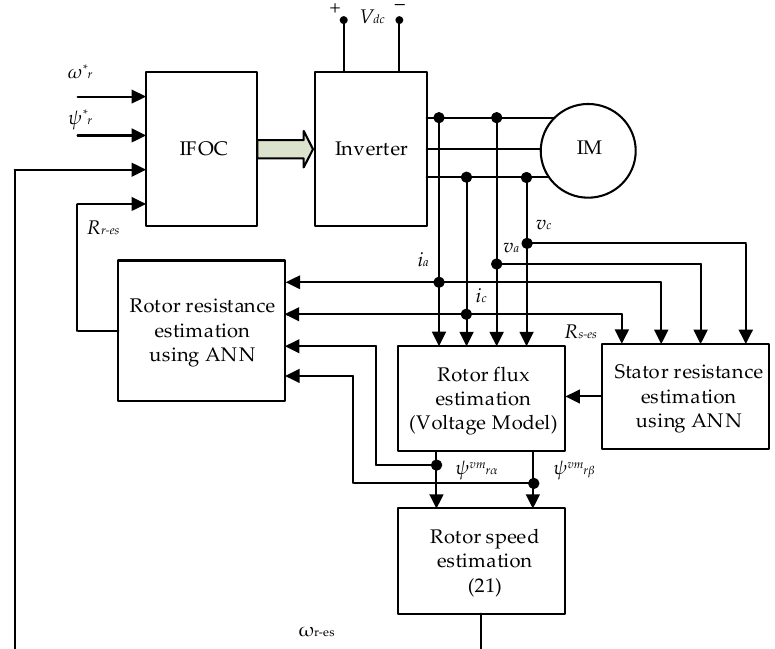
Figure 5. Diagram of indirect field-oriented control (IFOC) sensorless drive with online rotor and stator resistance estimation.